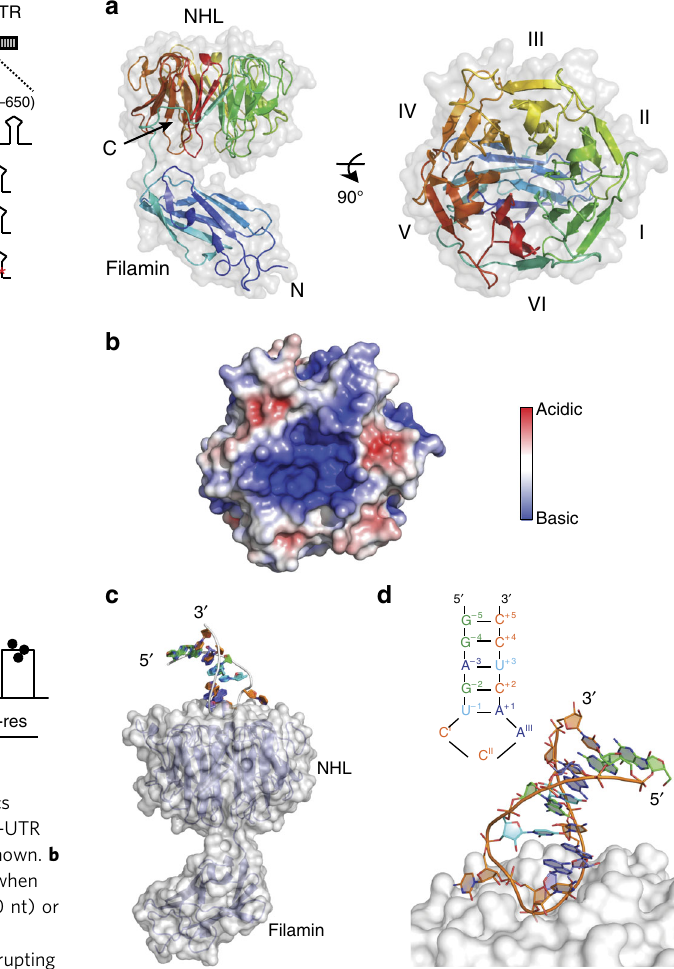
Fig. 4 Crystal structure of the C-terminal part of D. rerio LIN41. a The crystal structure of the DrLIN41 fi lamin-NHL domains is displayed in a cartoon mode, with a transparent grey surface in two orientations rotated by 90°. The molecule is colored from blue (N terminus) to red (C terminus) to indicate the topology. Protein domains, termini, and β -propeller blades are labeled for better clarity. b Top view of the RNA-binding site of the DrLIN41 NHL domain with the electrostatic surface potential mapped onto the molecular surface. Surface potential is computed by using the APBS plugin implemented in PyMOL (www.pymol.org) and is displayed from – 5.0 kT/e (red, acidic) to + 5.0 kT/e (blue, basic). c DrLIN41 fi lamin-NHL domains in complex with the lin-29A stem-loop RNA. The fi lamin and NHL domains are shown in cartoon mode in blue, with a white transparent surface. The lin- 29A RNA fragment, forming a hairpin, is displayed as a cartoon with nucleotides in different colors (guanine: green, adenine: blue, cytosine: orange, uracil: cyan). d Magni fi ed view of the lin-29A RNA stem loop bound to the DrLIN41 NHL surface (colors as in c ). A diagram detailing the nucleotide composition of the stem loop is shown above